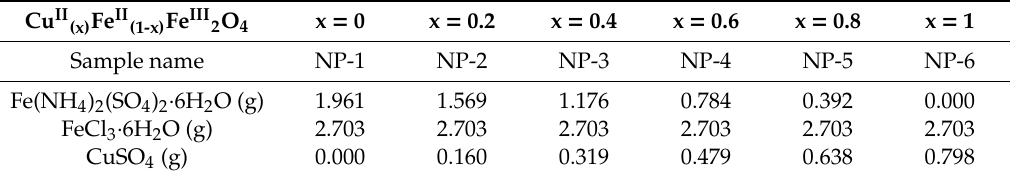
Table 1. Design of experiments for nanoparticles (NPs)